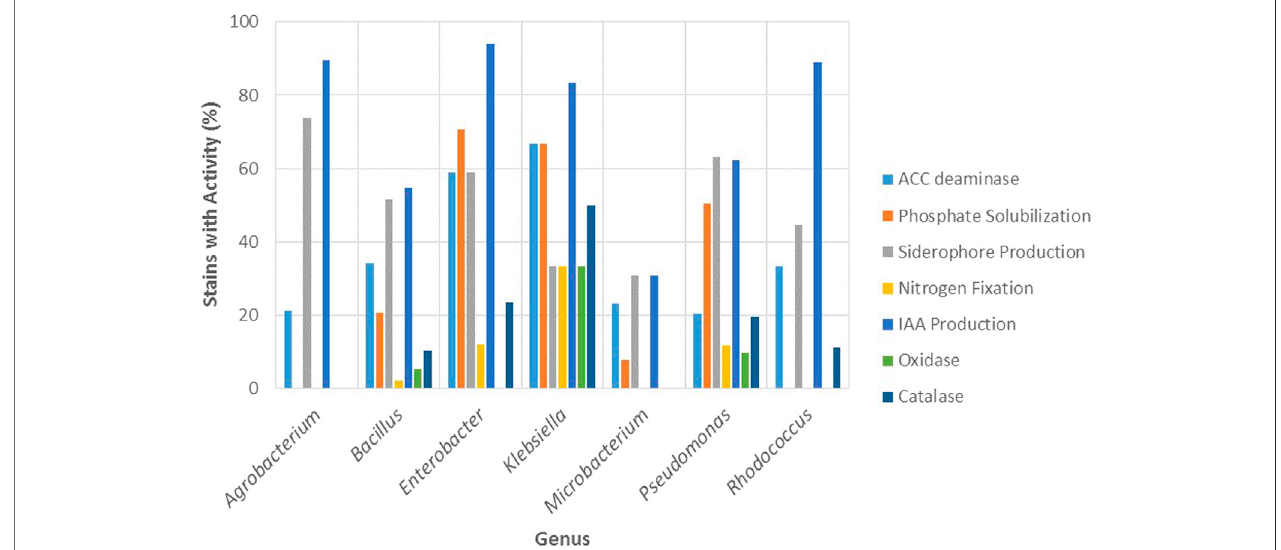
FIGURE 7 | Percentage of strains with activity for the most commonly reported PGP traits (ACC deaminase, phosphate solubilization, siderophore production, nitrogen fi xation and IAA production) and enzymatic properties (oxidase and catalase) in function of most resistant bacterial genera ( Agrobacterium, Bacillus, Klebsiella, Enterobacter, Microbacterium, Pseudomonas and , Rhodococcus ).